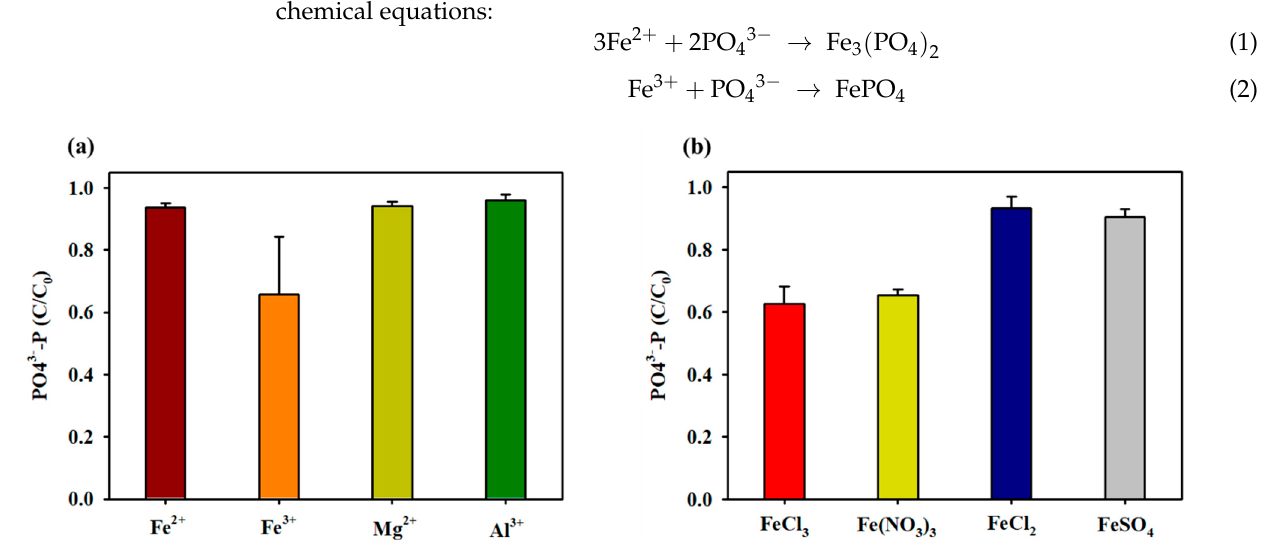
Figure 1. Removal of T-P by ( a ) different cation solutions and ( b ) Fe solutions with different anions. Experimental conditions: [cations] = 1 mM, [PO 43 − -P] 0 = 100 mg·L − 1 .